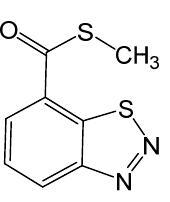
Figure 1. Chemical structure of benzothiadiazole.